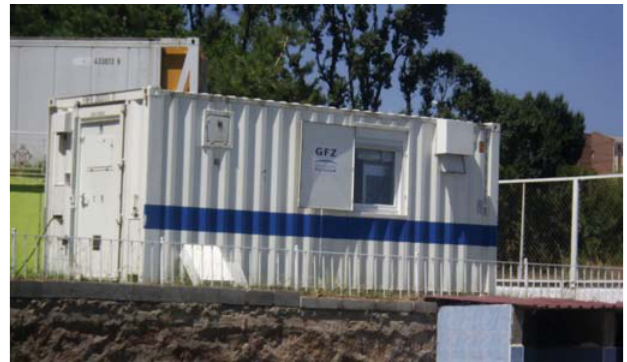
Figure 10. The mobile container laboratory BUGLab operated by GFZ Potsdam located at the shore of Lake Van during the ICDP drilling